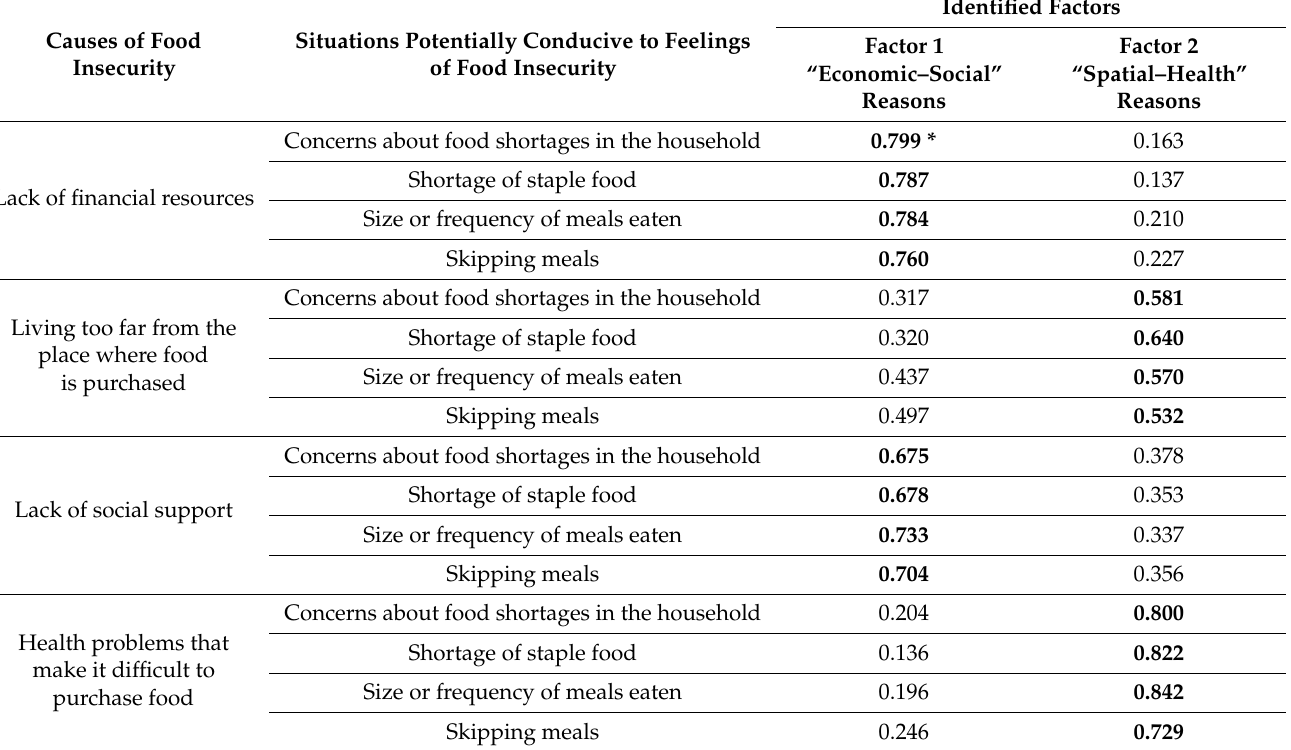
Table 2. Factor load matrix for food insecurity reasons extracted using Varimax